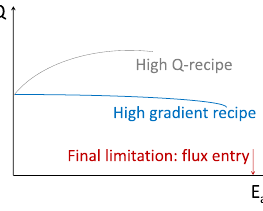
FIG. 1. Generic plot of the quality factor Q as a function of the accelerating